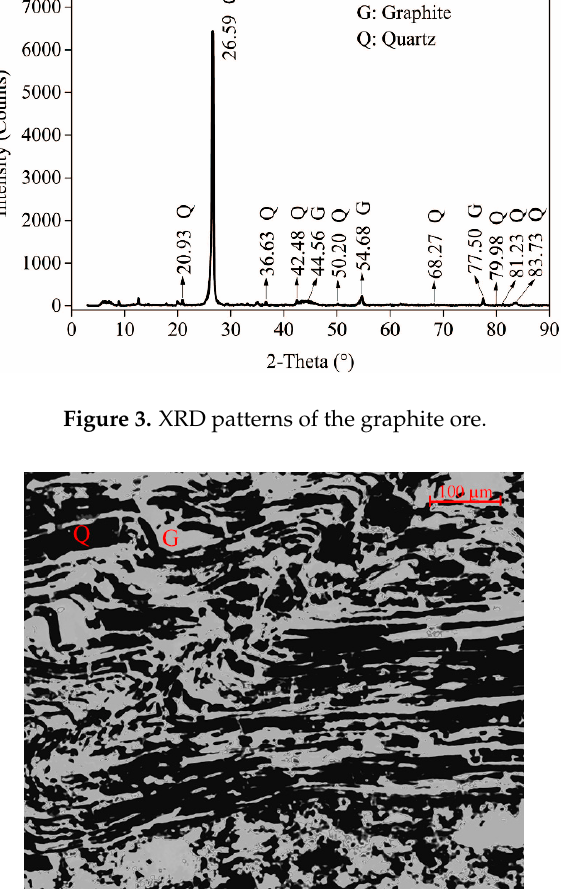
Figure 4. Petrographic image of the graphite ore (Q-quartz, G-graphite).